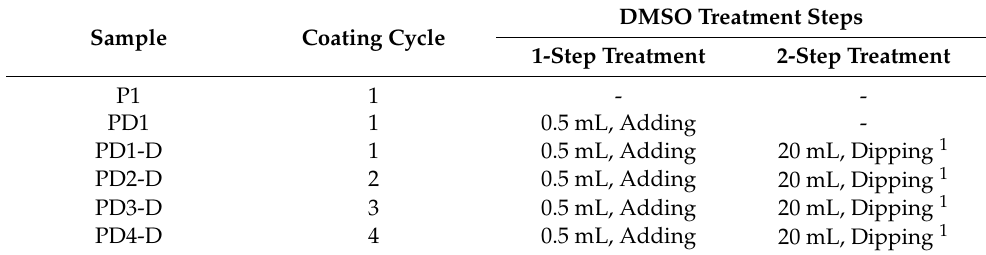
Table 3. Experimental design for the conductive